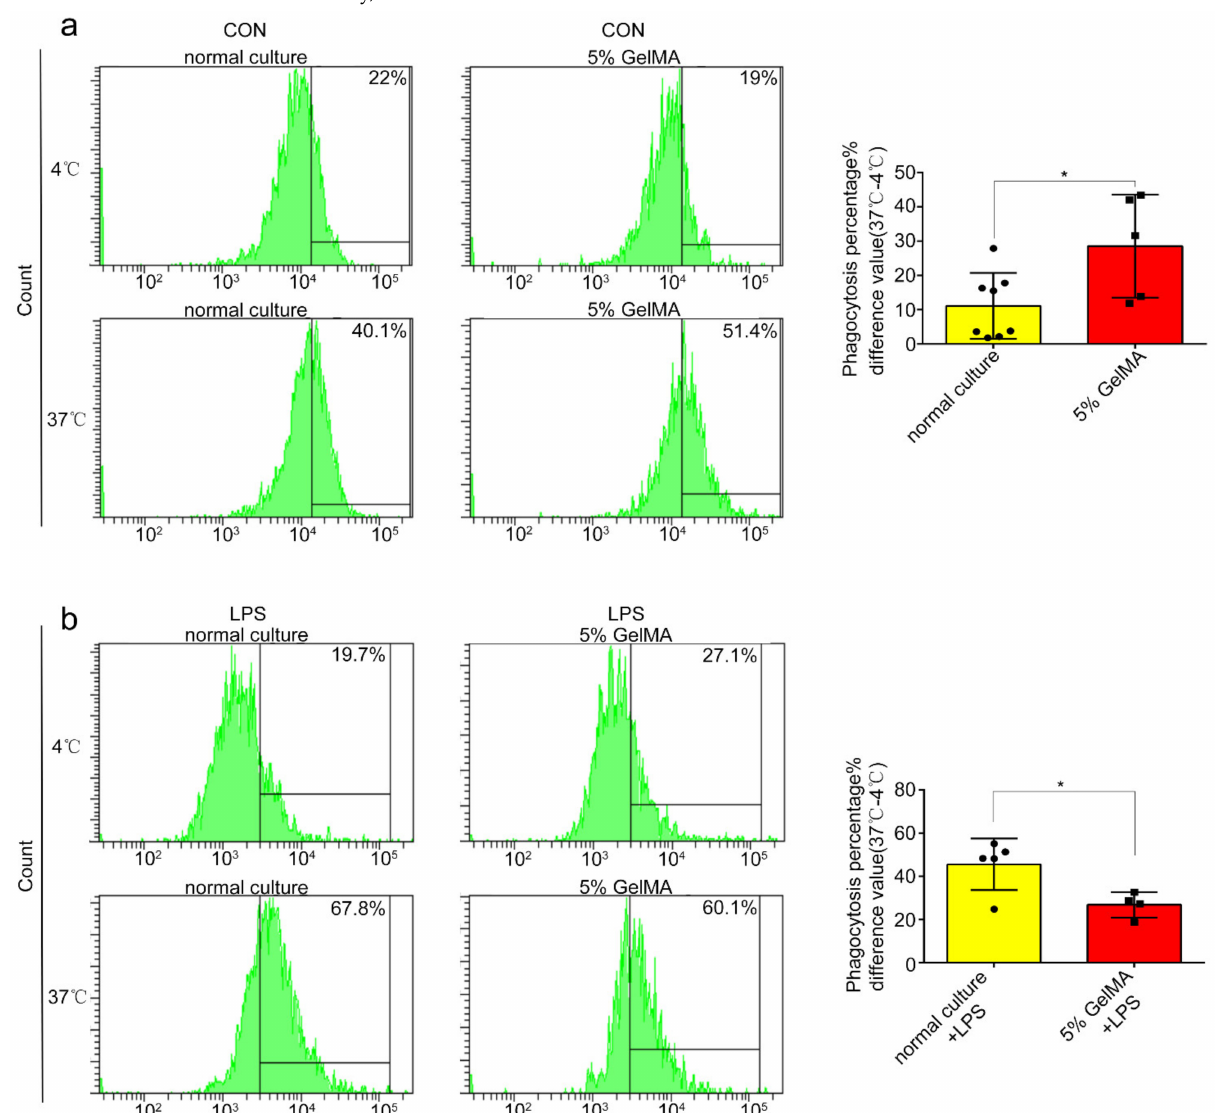
Figure 5. BMDCs cultured on 5% GelMA-30 with more potential for antigen uptake. ( a , b )